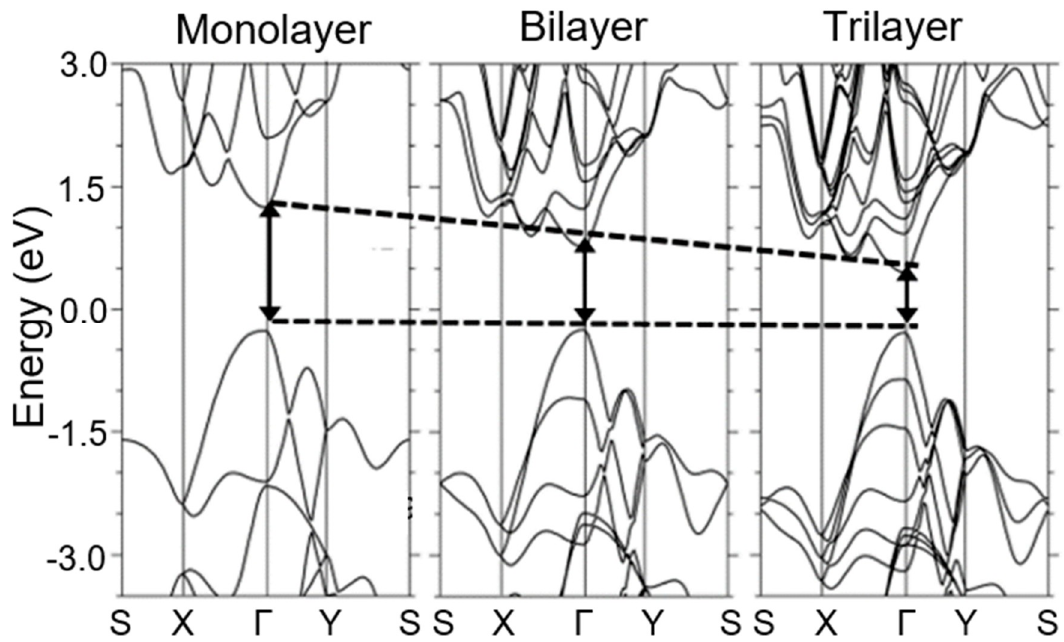
Figure 2. Electronic structures of monolayer, bilayer and trilayer black phosphorus calculated using first principles. Direct band gap of each layer is presented with black arrow at gamma position. The energy is scaled with respect to the Fermi energy. Reproduced from Ref. [53]. Published by IOP Publishing LTD as open access, 2014.